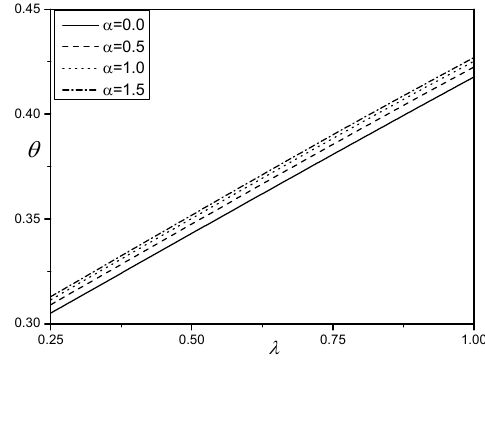
Fig. 19 Slip parameter α effect on θ ( λ )